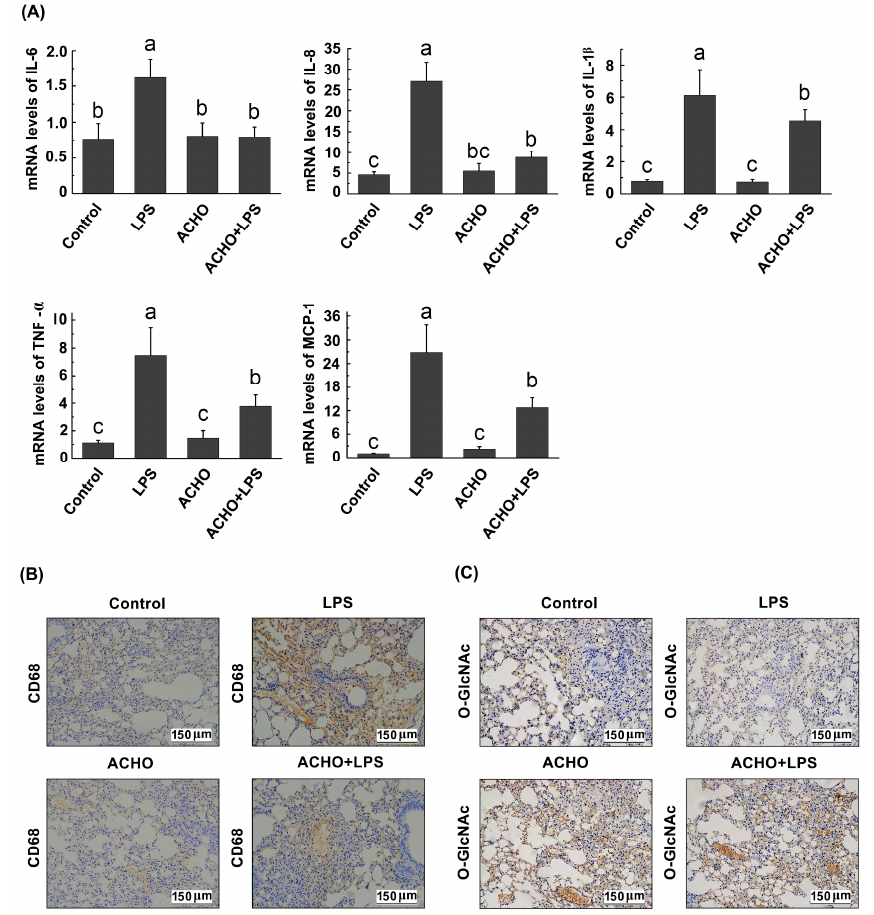
Figure 7. Effect of ACHO on transcriptional activation of pro-inflammatory cytokines ( A ), macrophage infiltration ( B ) and protein O -GlcNAcylation ( C ) in lung tissues of LPS-injected mice. C57BL/6 mice were pre-treated with ACHO (1 mg/mL in drinking water) for two weeks followed by LPS (3 mg/kg) injection intraperitoneally for 24 h. After that, mice were euthanized, and lung tissues were collected for RT-PCR assay or immunochemistry assay. ( A ) Expression of pro-inflammatory cytokines at mRNA level in lung tissues of LPS-injected mice, including IL-6, IL-8, IL-1 β , TNF- α and MCP-1; ( B ) Effect of ACHO on CD68 (cluster of differentiation 68) production in lung tissues of LPS-injected mice ( × 200); ( C ) Effect of ACHO on protein O -GlcNAcylation in lung tissues of LPS-injected mice ( × 200). Data represent the mean ± SD ( n = 5). Data with different superscript letters are significantly different ( p <